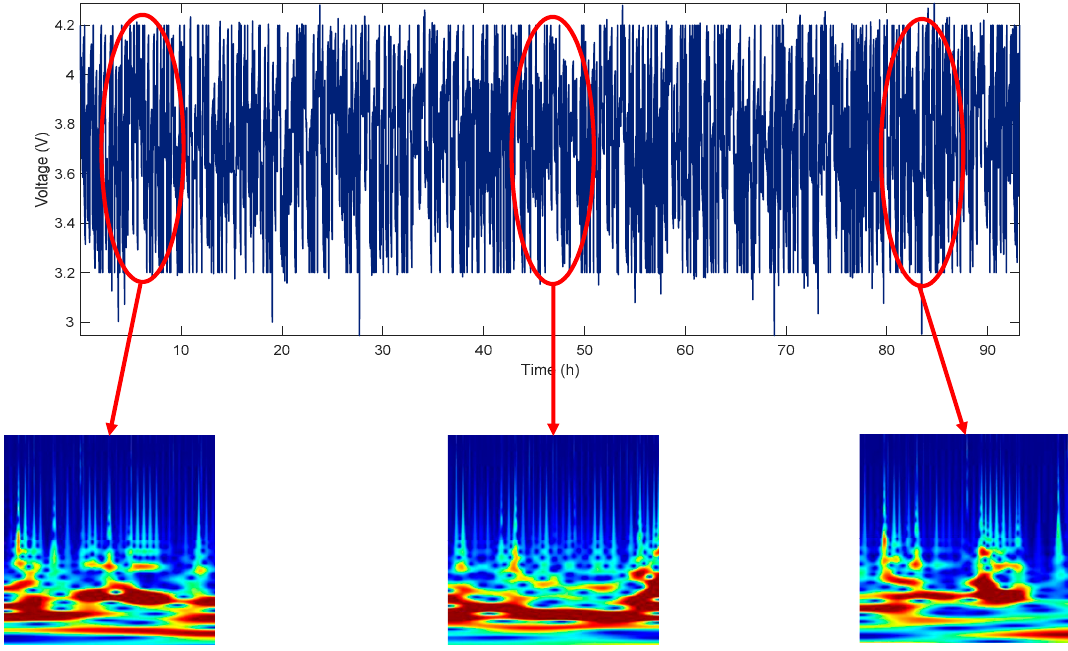
Figure 6. Measured voltage of lithium-ion battery and transformed TFI energy concentration spectrum information of the measured voltage at three different capacity values.